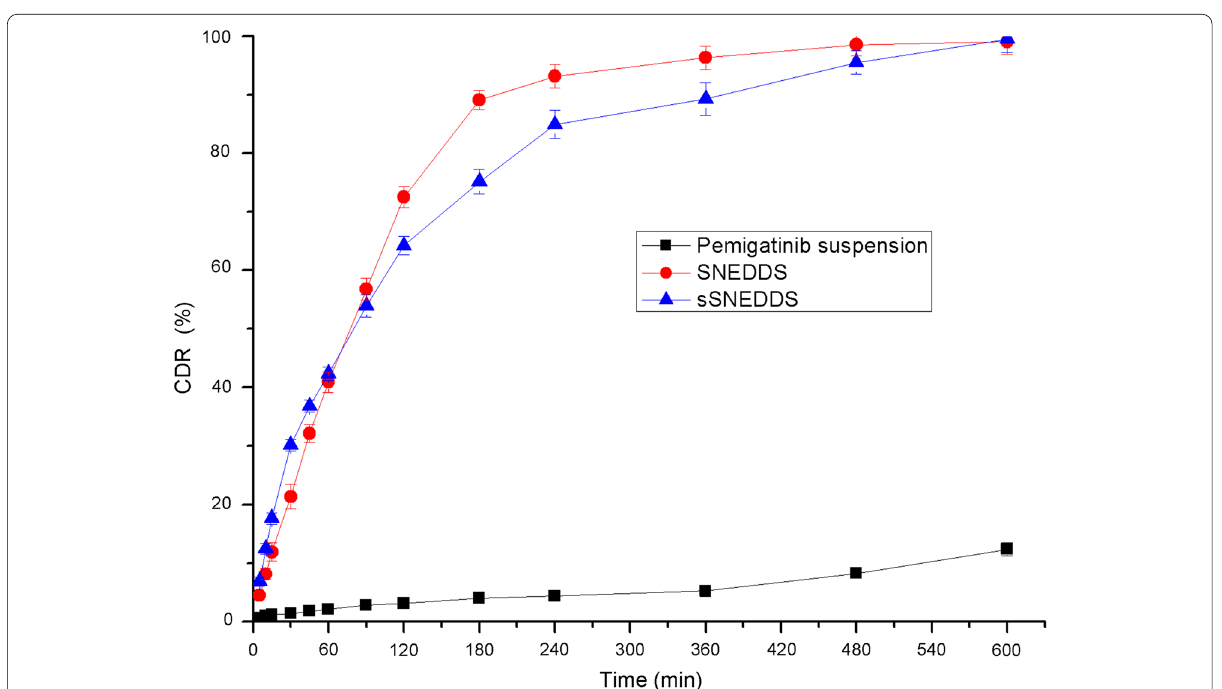
Fig. 12 Dissolution profile of Pemigatinib from sSNEDDS